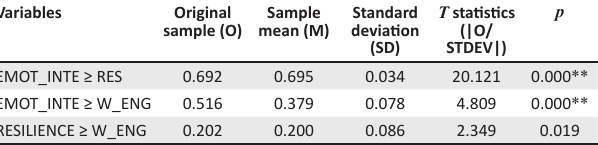
TABLE 6 : Partial least squares path coefficient results. Variables